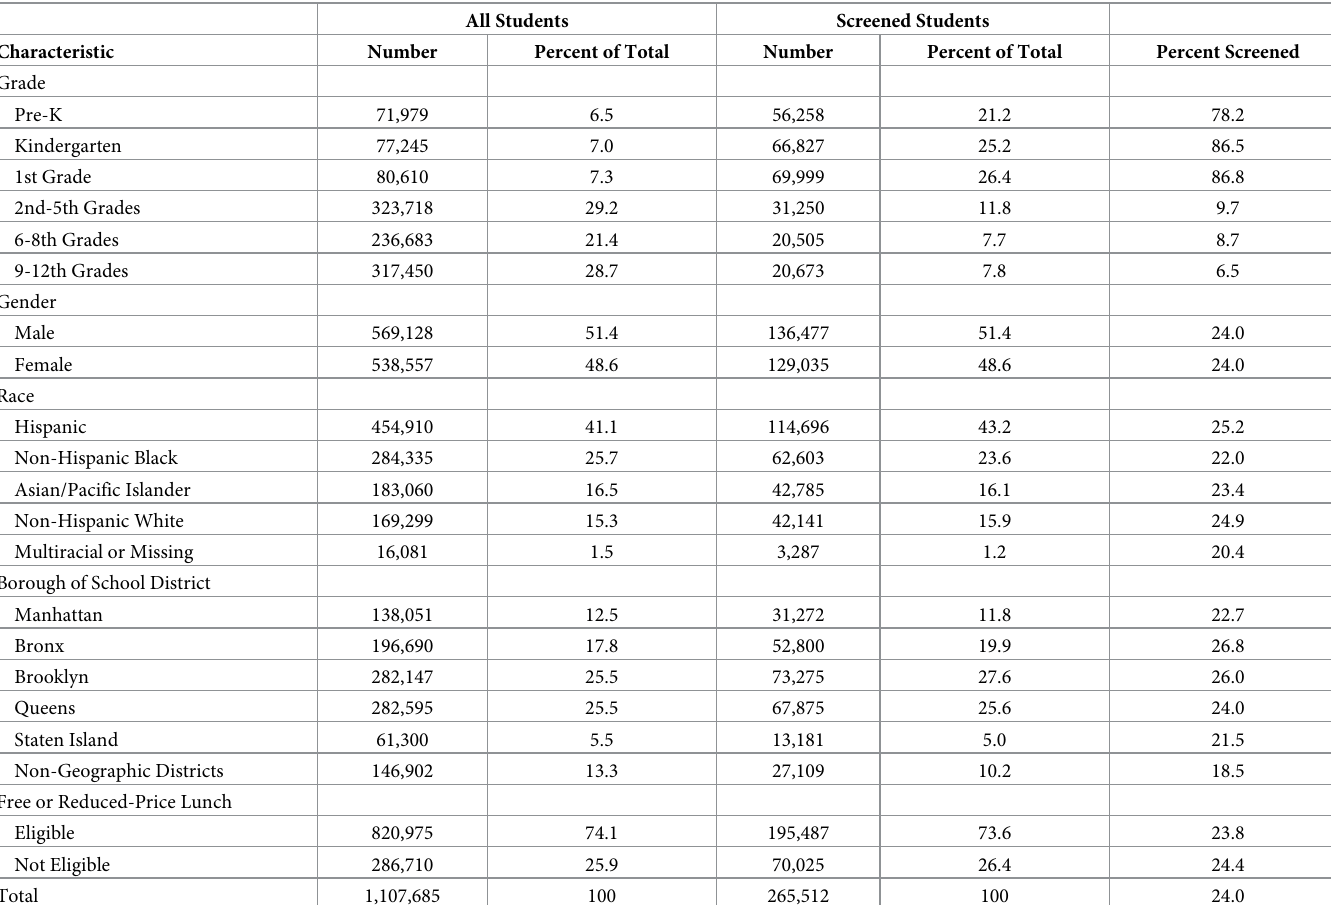
Table 1. Summary of demographic characteristics of students enrolled in NYC public schools and students screened by the School Vision Program, 2018–19. All